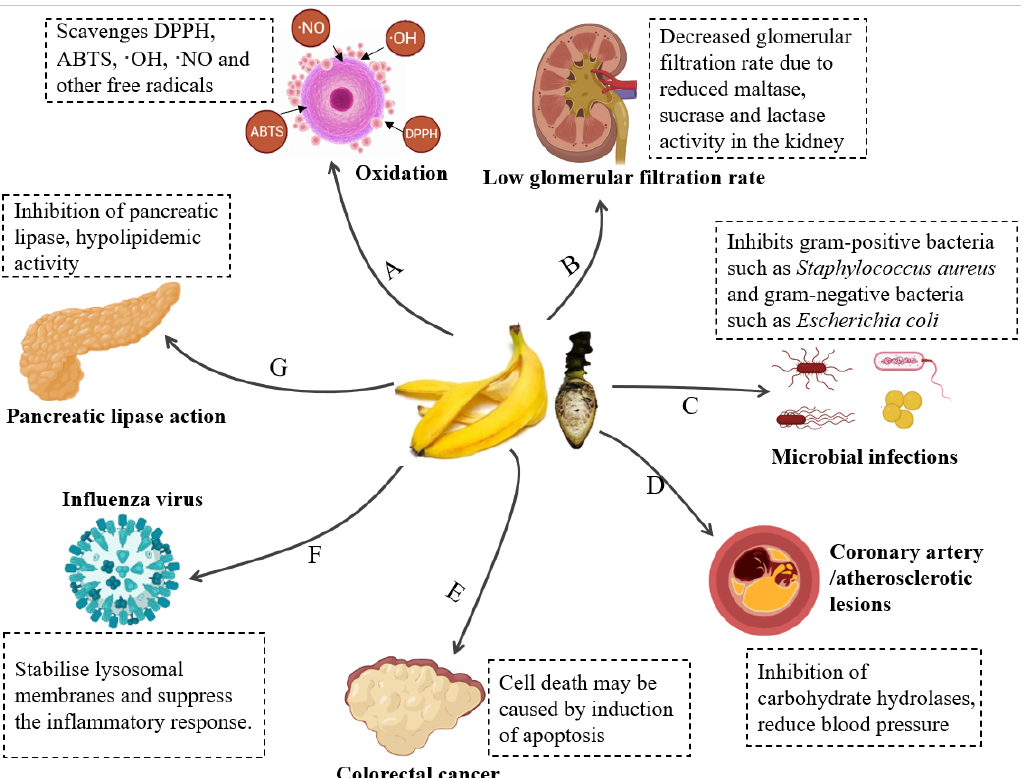
Figure 7. Schematic representation of the potential mechanisms of the health benefits of banana by-products and their corresponding bioactive components: (A) antioxidant, (B) antidiabetic, (C) antimicrobial, (D) anti-cardiovascular disease, (E) anticancer (F) anti-inflammatory, (G) anti-obesity.